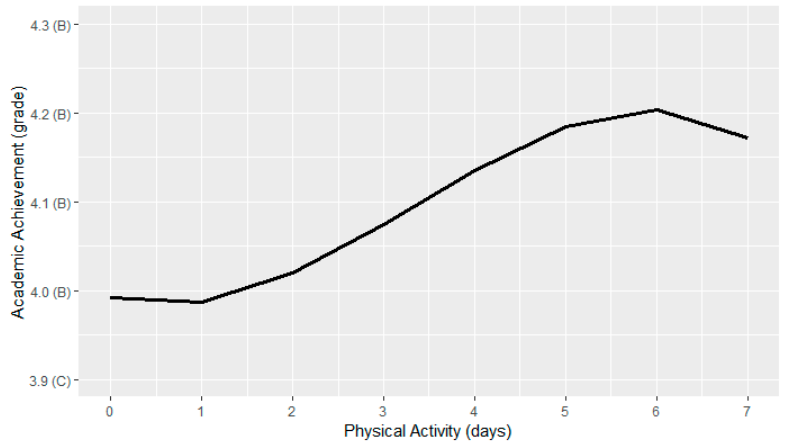
Figure 1. Relationship between physical activity and academic achievement. Figure 1 . Relationship between physical activity and academic achievement.